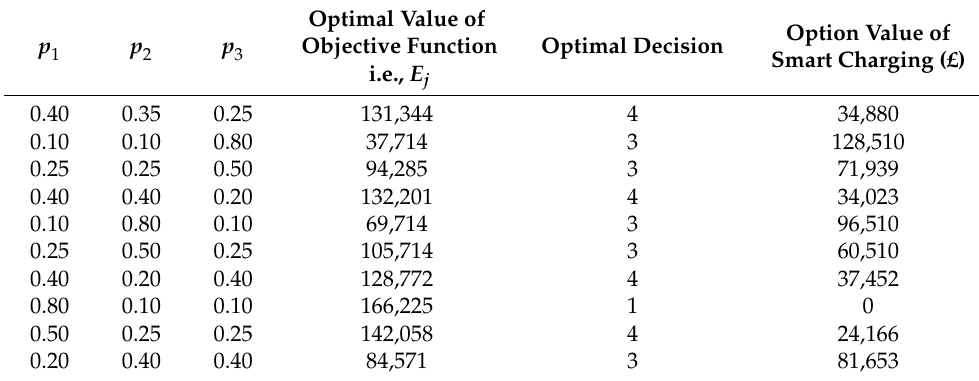
Table 5. Sensitivity analysis on the scenario probabilities, using